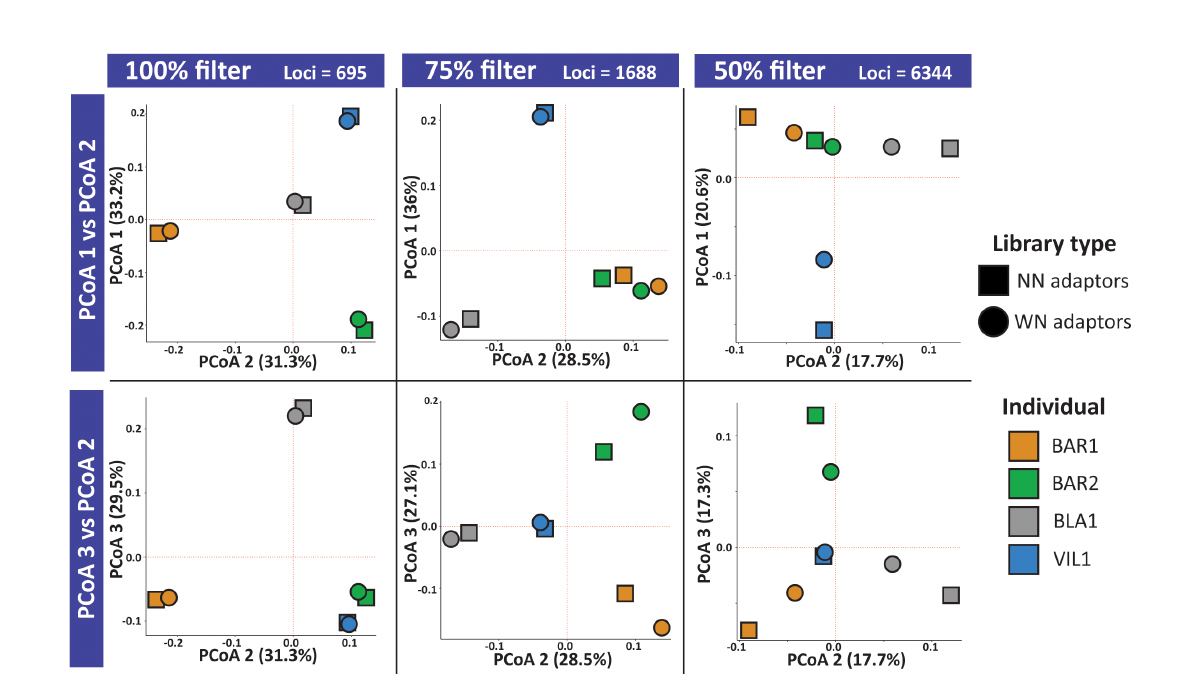
FIGURE 1 Principal coordinate analysis (PCoA) for the fi rst three components based on Prevosti ’ s distances among libraries. Analysis performed with the combined (NN-WN) dataset for the fi lters of 100%, 75% and 50% loci presence. In the upper row, we plotted the fi rst (y axis) and the second (x axis) components of the PCoA, while in the lower row we plotted the third (y axis) and the second (x axis)